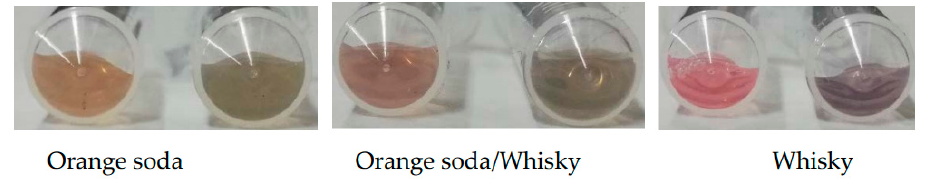
Figure 4. Color changes in real samples. Please notice that, in all cases, the vials are grouped in pairs, and the first vial contains the clean sample; meanwhile, the second one contains the spiked